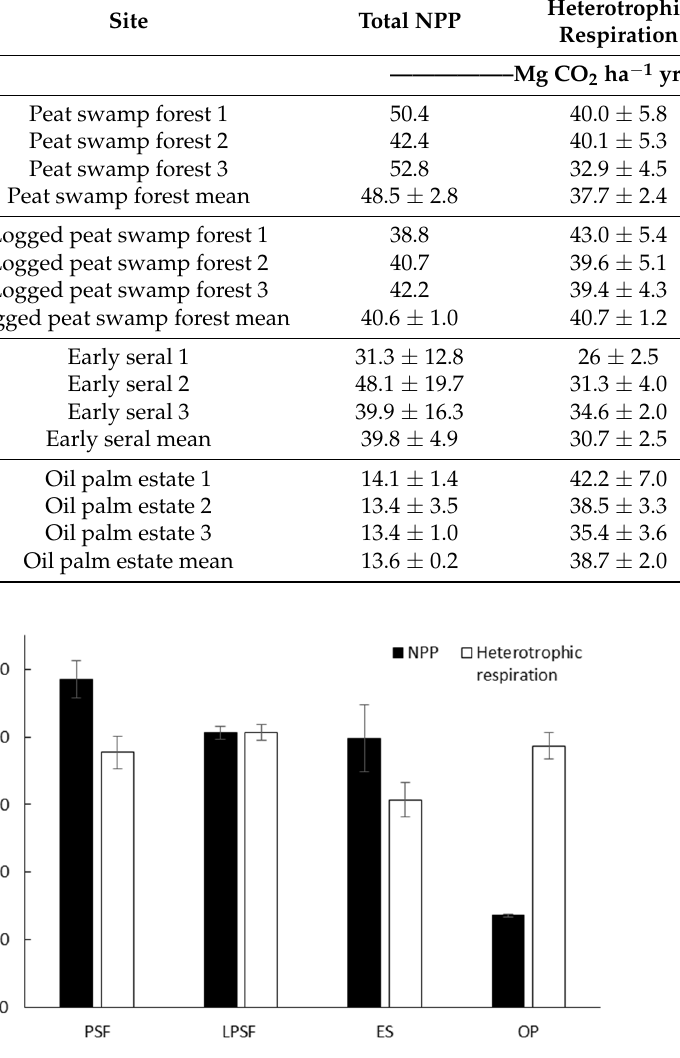
Figure 5. The net primary production and heterotrophic respiration rates in intact (PSF), logged peat forests (LPSF), early seral communities (ES), and oil palm estates (OP). Vertical bars are one standard error of NPP and respiration.